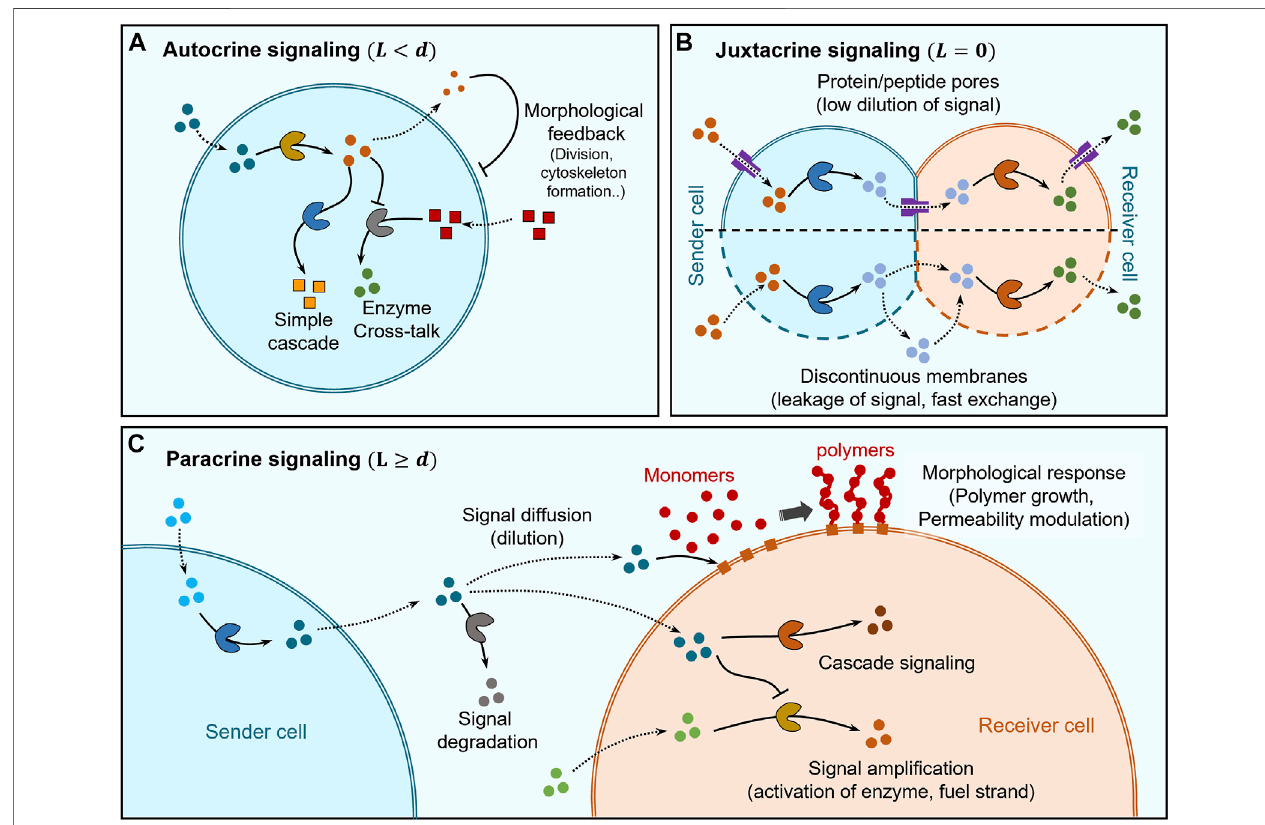
FIGURE2 | Distance based classi fi cation ofsignaling. (A) Self-signaling (autocrine signaling) within arti fi cial cellscan be mediated by simple enzyme cascades and enzymecross-talk toself-modulatechemicalbehaviourwhilemorphologicalchangescanalsobeelicitedviacytoskeletonformationanddivisionintosecond-generation cells. (B) Juxtacrinesignaling occurs betweensender and receivercells thatarein directcontactand its regulation depends onthe typeofmembranesseparatingthem. In the case of sender and receiver cells having continuous membranes (lipid bilayers), the insertion of protein/peptide pores into the membrane allows regulation of communication betweenthemselvesand withtheenvironmentwhile also avoiding dilutionofsignaling moleculesdue tolimited pore channels. Sender and receiver cells having discontinuous membranes exhibit fast-unchanneled exchange of signaling molecules between themselves and the environment. (C) Paracrine signaling occurs betweensenderand receivercellswhichareseparatedbydistanceslargerthantheirsize.Thesignaling moleculesget dilutedandmaybedegradedbeforereachingthe receiver cell, where they can trigger a chemical response via cascade signaling or undergo ampli fi cation for increasing the signaling distances. Signaling molecules can also trigger morphological responses, for e.g., via activating membrane-immobilized chain growth agents leading to polymer brush growth on the membrane of the receiver cell allowing modulation of permeability.